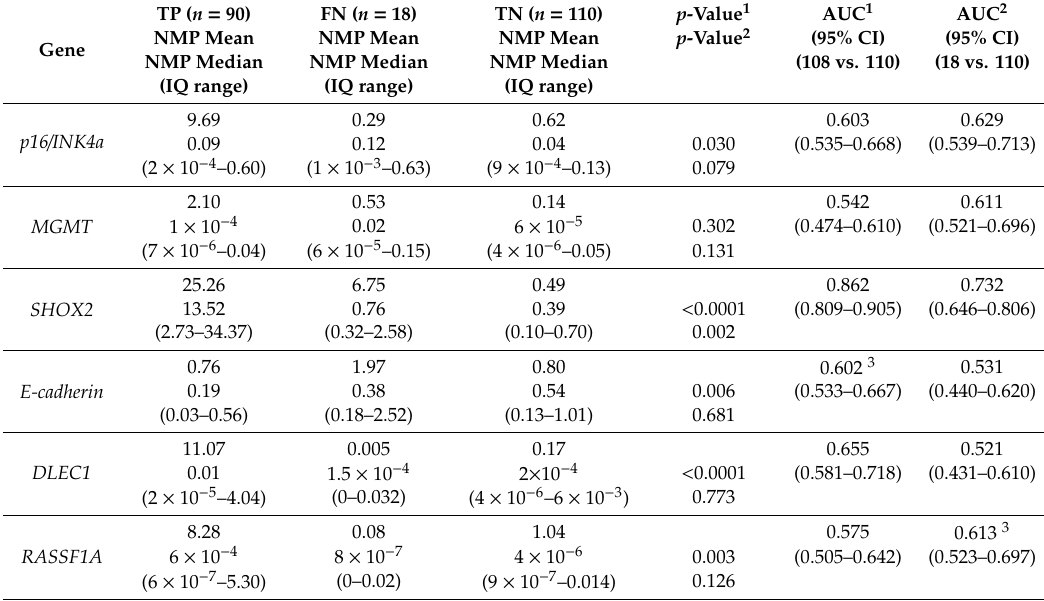
Table 3. Normalized methylation percentages of candidate genes according to EBUS-TBNA and final diagnosis.